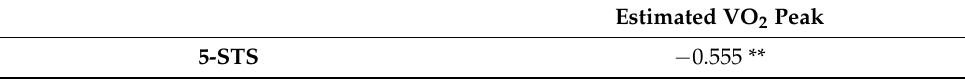
Table 2. Bivariate correlation (r, p ) between the 5-STS and the 6MWT (distance and estimated VO 2 peak).